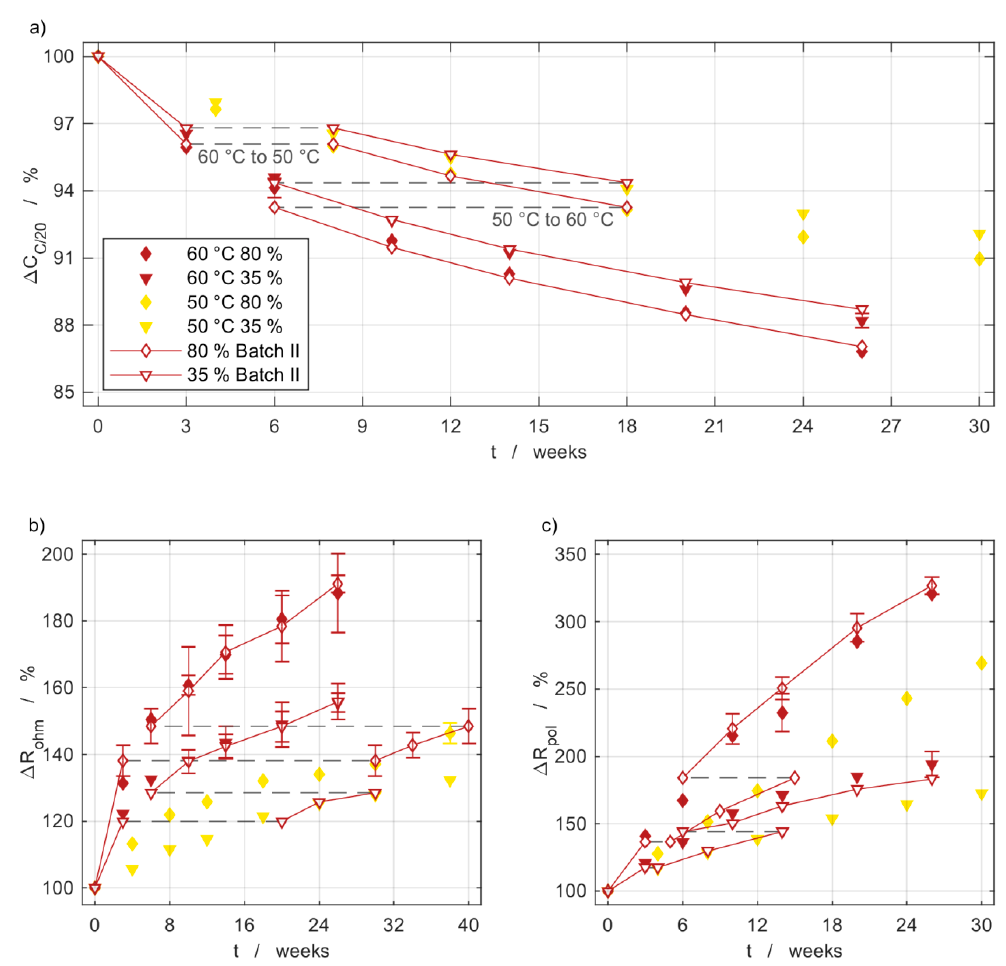
Figure 3. Comparison of Batch I and Batch II cells at 80% and 35% SoC, including two temperature changes between 60 ◦ C and 50 ◦ C; ( a ) Discharge capacity fade and increase in ECM parameters ( b ) ohmic resistance and ( c ) polarization resistance. The filled-in markers represent cells of Batch I, and the gray dashed lines indicate the two temperature changes.